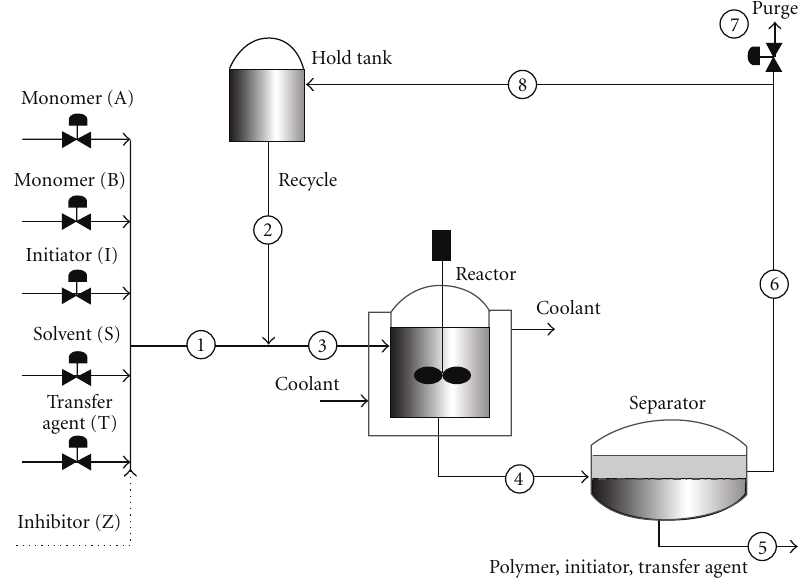
Figure 1: Basic process configuration